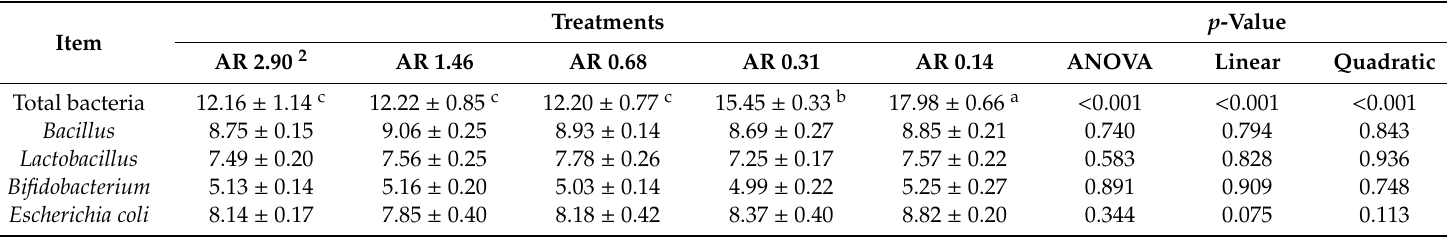
Table 9. E ff ects of dietary starch structure on the cecal bacterial community in weaned piglets (log (copies · g − 1)) 1 (mean values with their standard